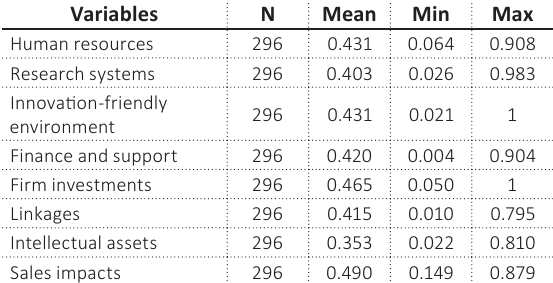
Table 2. Descriptive statistics of the variables